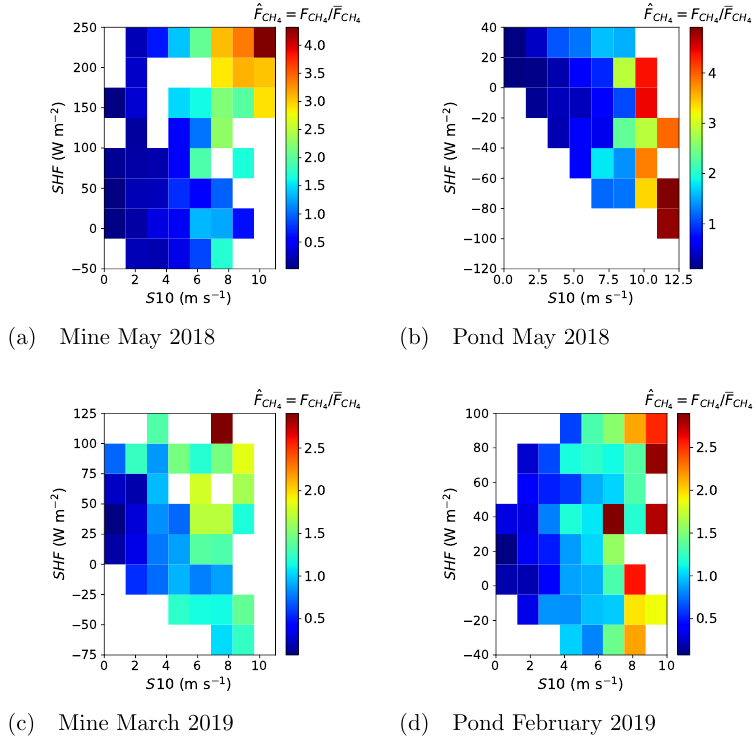
Figure A4. Colour plot of simulated normalized advective flux of methane ( ˆ F CH at 10 m ( S 10) and Sensible Heat Flux ( SHF ) values; median normalized advective flux of methane is shown in each tile; ( a ) Mine May 2018; ( b ) Pond May 2018; ( c ) Mine March 2019; ( d ) Pond February